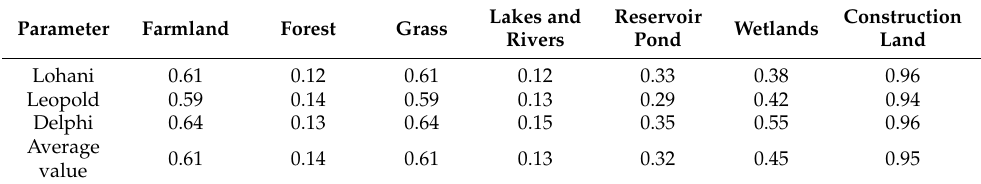
Table 4. Human activity intensity